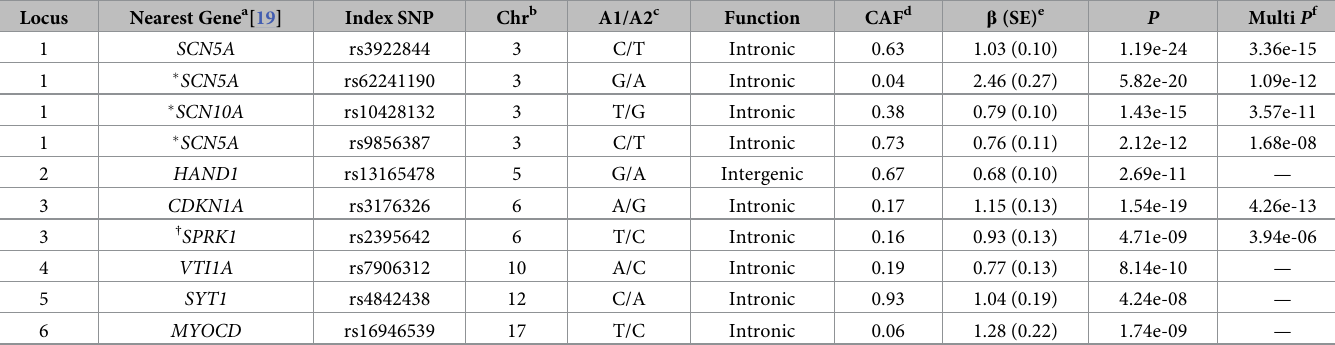
Table 1. Genome-wide significant SNPs identified in a GWAS meta-analysis of n = 15,124 participants of Hispanic/Latino ancestry from four studies. Locus Nearest Gene a